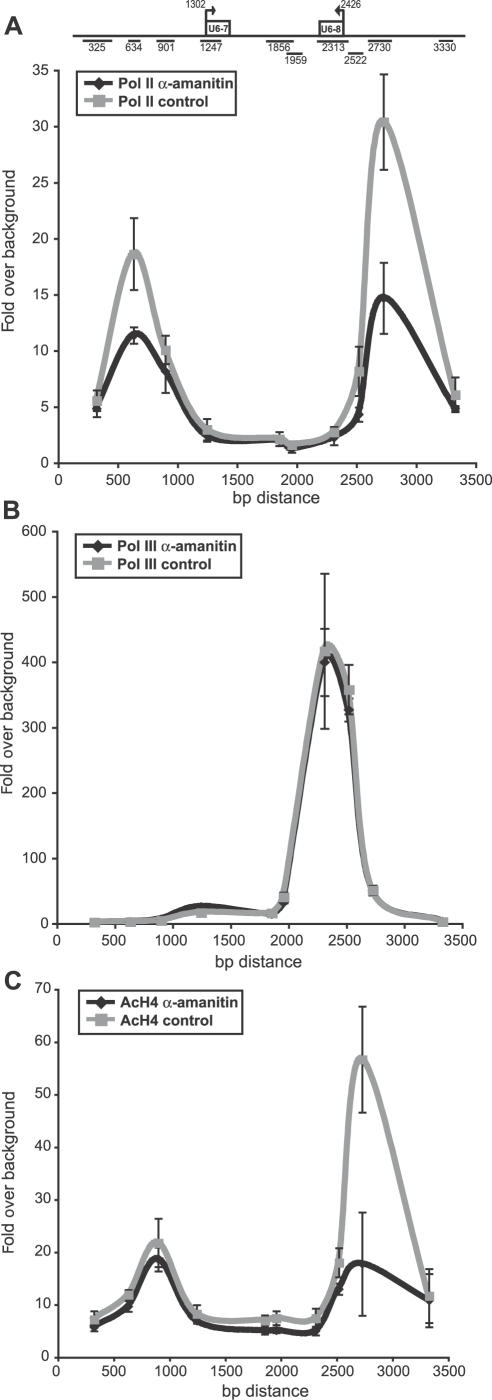
Pol II and Histone Acetylation Levels at U6 Genes Are Reduced by α-AmanitinExtracts from crosslinked Hela cells, either treated for 9 h with 10 μg/ml α-amanitin or left untreated, were subjected to ChIP with (A) Pol II, (B) Pol III, or (C) acetylated histone H4 antibodies. Purified DNA was subjected to qPCR with primers along U6–7 and U6–8 gene regions. All values are relative to background and normalized to an intergenic control region. Error bars represent the SEM. The data represents the average of three to five independent experiments.